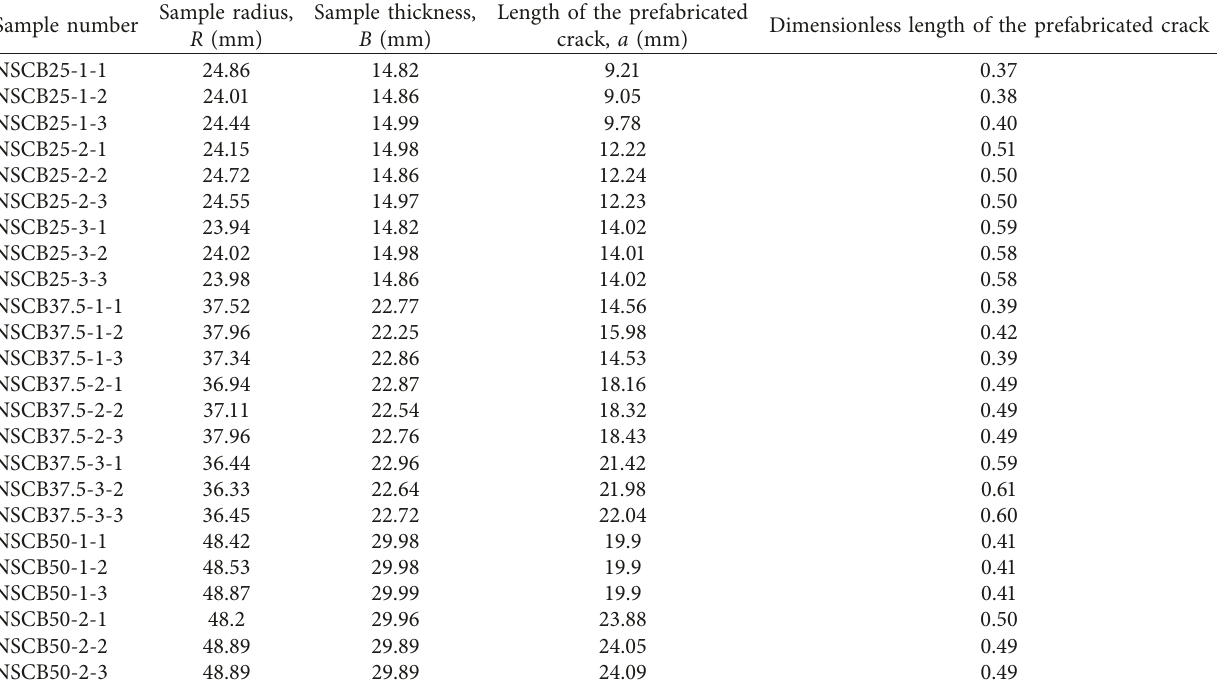
Figure 2: Sample preparation process. (a) Drilling the rock. (b) Creating the discs. (c) Grinding the rock face. (d) Making the artificial seam. Table 1: Geometric dimensions of the